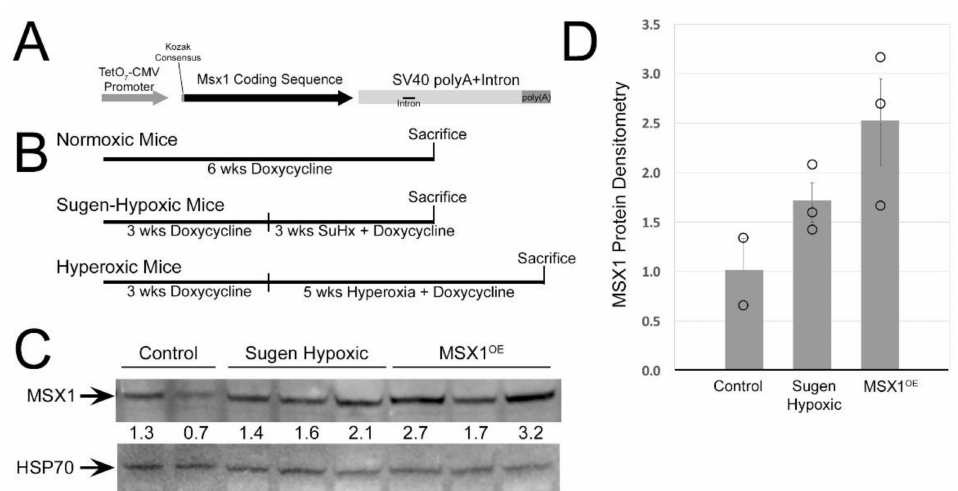
Figure 1. MSX1 expression is increased in Msx1 OE mice. Msx1 ( A ) design of the construct used to make the MSX1 OE mice; they were then crossed with Rosa26-rtTA2 mice, and fed doxycycline to initiate expression. ( B ) Schematic representation of experimental design for each treatment. ( C , D ) Protein expression is increased in Msx1 OE mice compared to control and sugen-hypoxia-treated